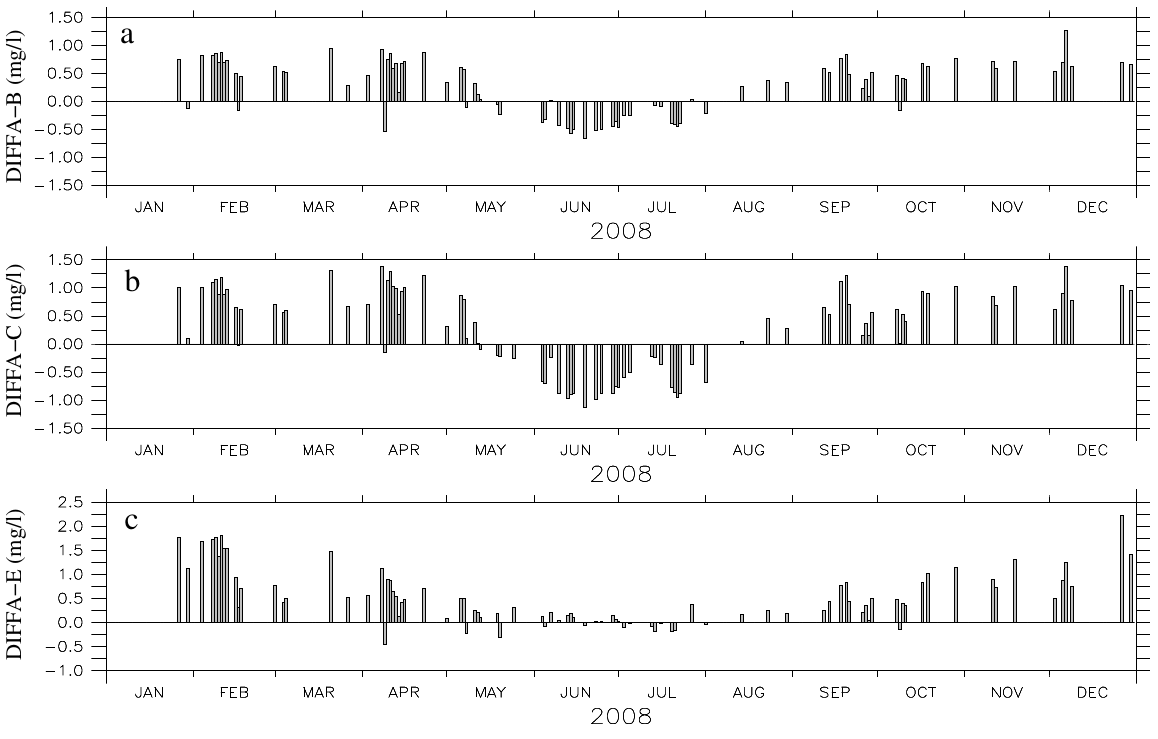
Figure 9. Temporal evolutions of spatially-averaged differences ( a ) DIFF and ( c ) DIFF . Positive values indicate improved estimations of near-surface SSC with A − E configurations ( a ) B, ( b ) C and ( c ) E,